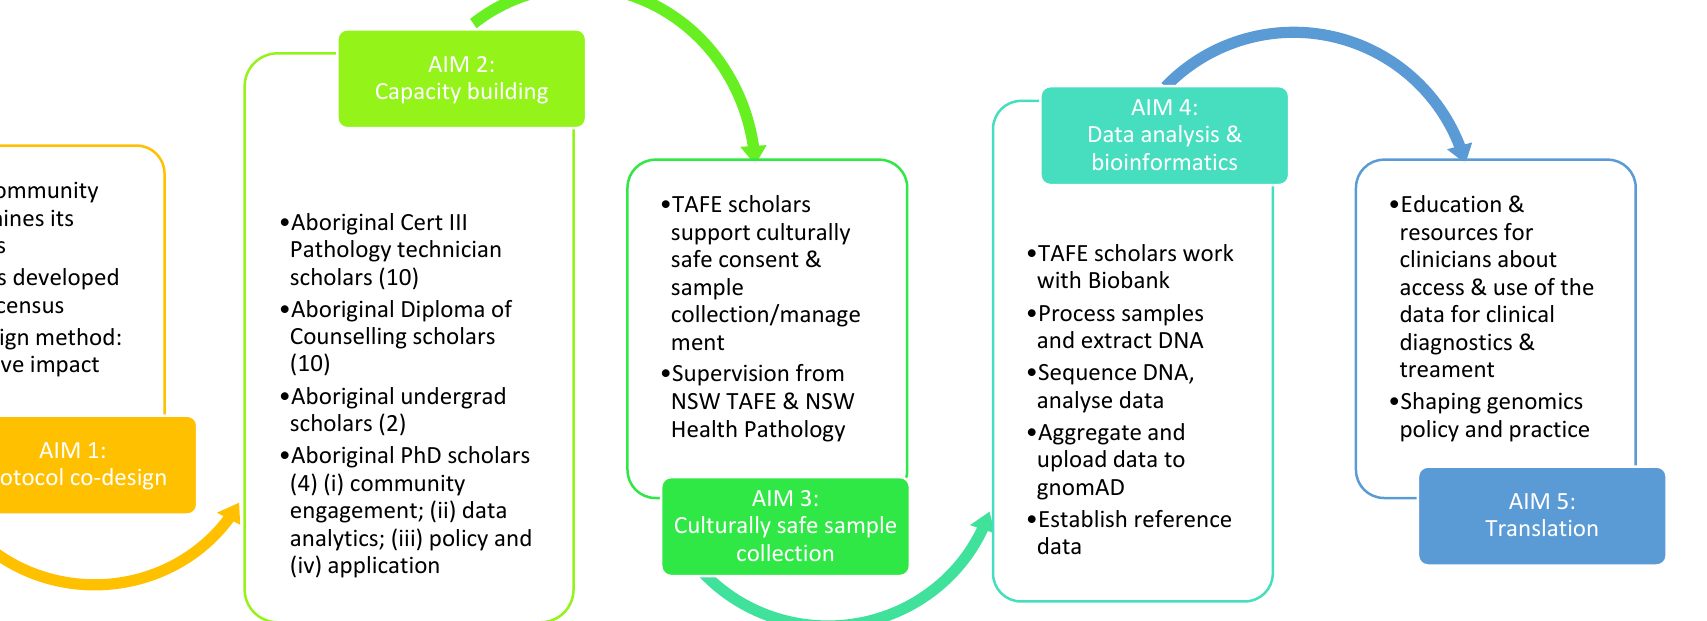
Figure 2. Five aim approach to enable Aboriginal Precision